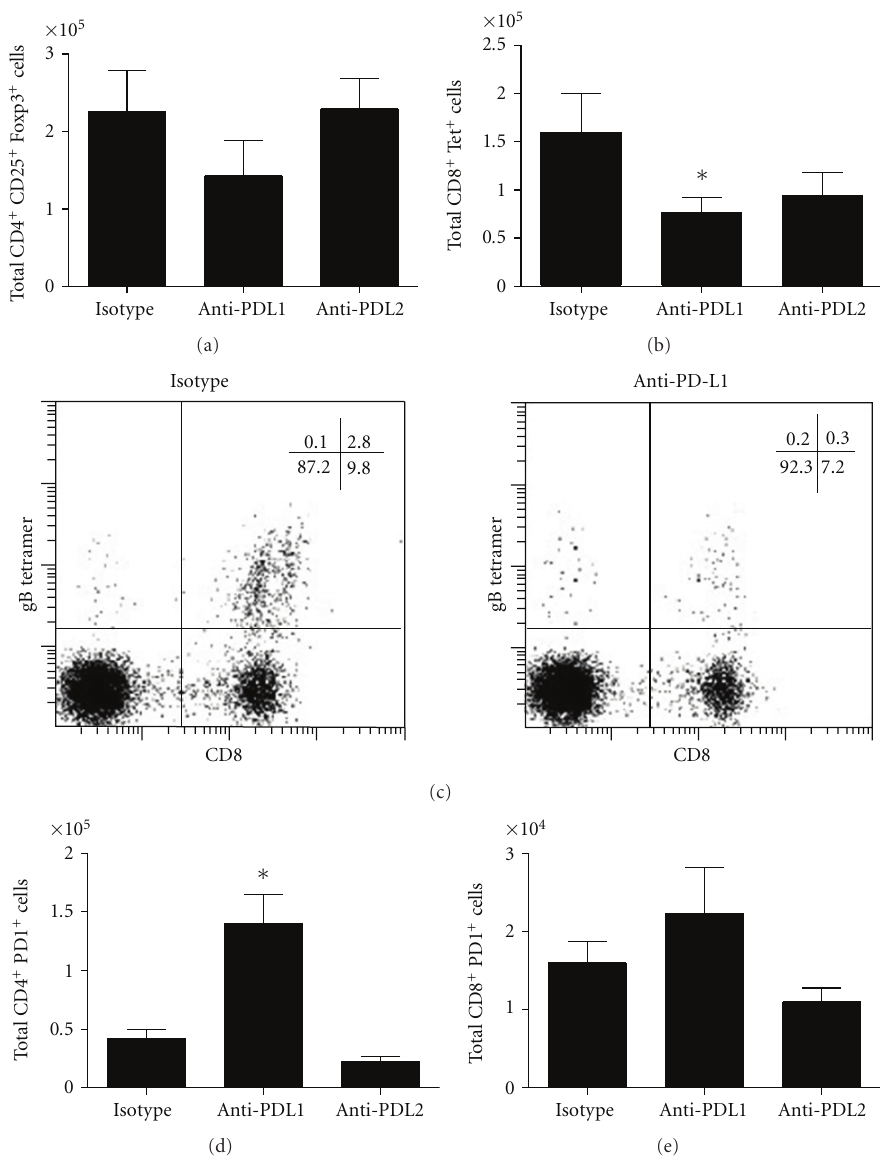
Figure 3: MLN T-cell subpopulations following HSV-1 infection and treatment with anti-PD-L1 or anti-PD-L2 antibody. C57BL/6 mice were infected with 1,000 PFU HSV-1/cornea. At days 2, 4, and 6 p.i. mice were administered neutralizing antibody to PD-L1, PD-L2, or control IgG. At day 7 p.i. mice were exsanguinated and the MLN was processed for flow cytometry. (a) Total CD4 + CD25 + Foxp3 + cells. (b) Total CD8 + Tet + cells. (c) Representative flow diagrams of lymph node stained for CD8 and expression of the TCR specific for the HSV-1 gB-derived epitope SSIEFARL, as indicated by staining with tetramer. (d) Total CD4 + PD-1 + cells. (e) Total CD8 + PD-1 + cells. This figure summarizes three experiments ( n = 9). Each bar represents the mean ± SEM. ∗ P < 0 . 05 comparing the indicated group to the isotypic control antibody-treated